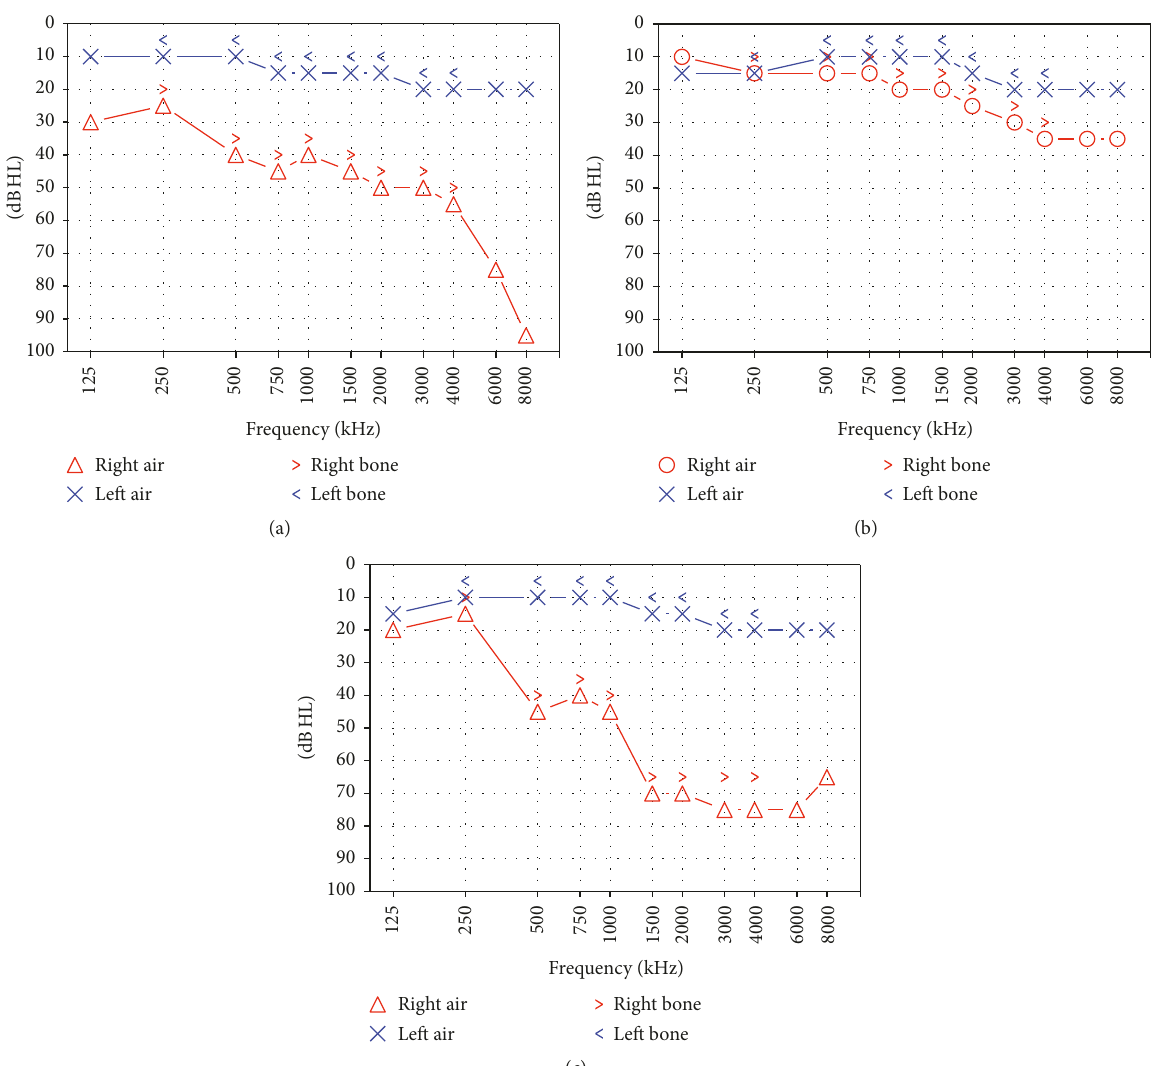
Figure 3: PTA in our patient recorded one, three, and 14 days after onset of Sudden Sensorineural Hearing Loss in the right ear (first episode). (a) Pure Tone Audiometry recorded one day after hearing loss onset showing a moderate sensorineural hearing loss in the right ear with an average auditory threshold of 49.54 dBHL and normal hearing threshold in the left side. (b) Pure Tone Audiometry recorded three days after hearing loss onset; hearing in the right side significantly improved (average threshold: 23.2 dBHL). (c) When recording Pure Tone Audiometry 14 days after sudden hearing loss onset, and 4 days after cessation of high-dose corticosteroid therapy, hearing in the right ear returned to previous levels with an average threshold of 54.09